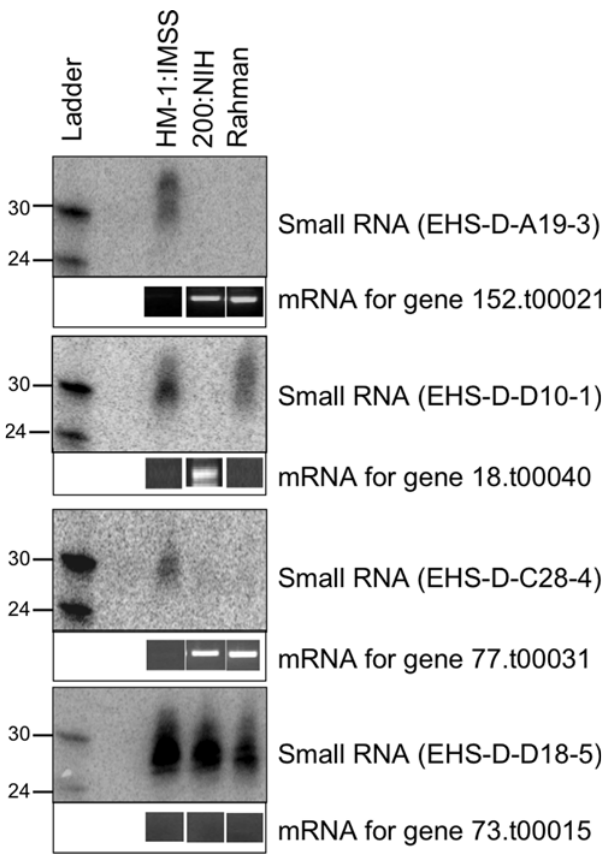
Figure 7. Small RNA expression levels correlate inversely with mRNA levels. A Northern blot (100 m g small RNA enriched sample each from E. histolytica trophozoites of strain HM-1:IMSS, 200:NIH, and Rahman) was probed with oligonucleotides to detect the expression level of the small RNA of interest. The same blot was stripped and probed for each small RNA as listed. RT-PCR for each gene from the appropriate strain is shown below the small RNA Northern blot. All controls for the RT-PCR reactions gave appropriate